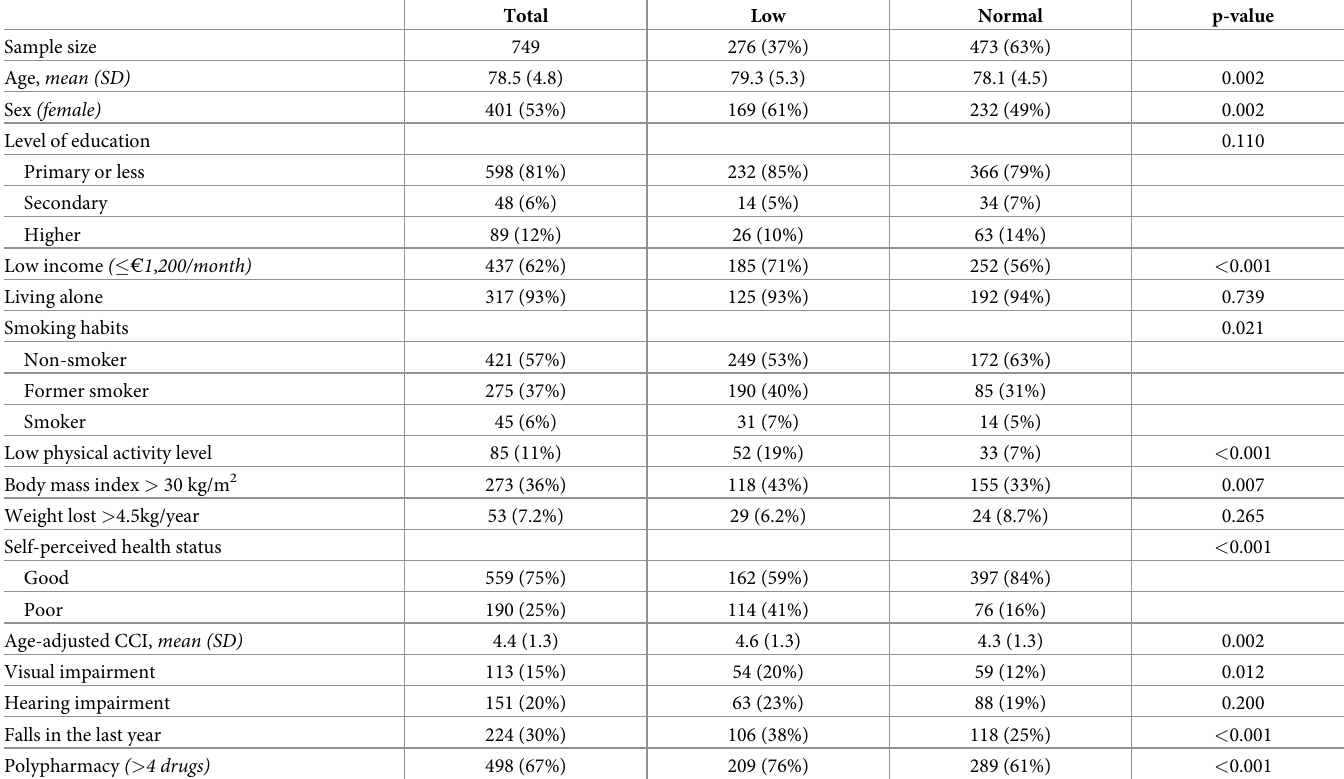
Table 1. Baseline description of the participants overall and by functional